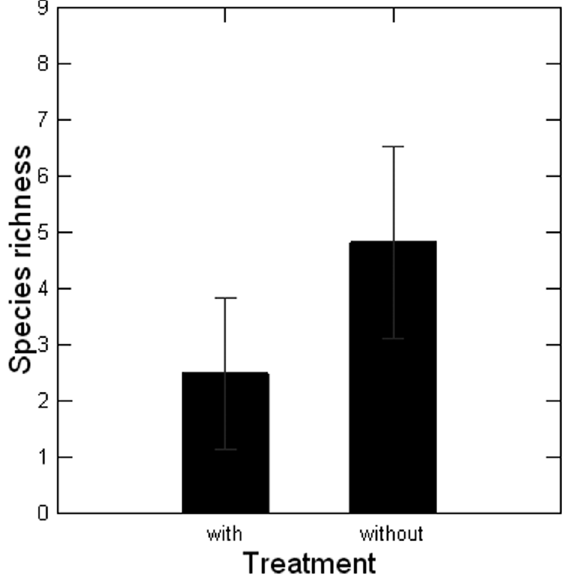
Figure 3 - Mean species richness of natural regeneration with (present) and without (absent) the presence of Urochloa decumbens (Stapf) R.D.Webster (Poaceae).